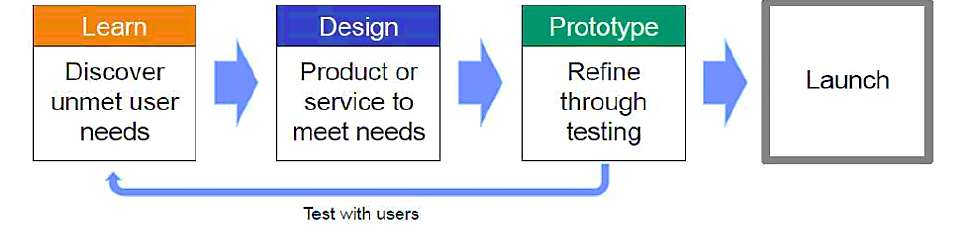
Figure 1. Product design